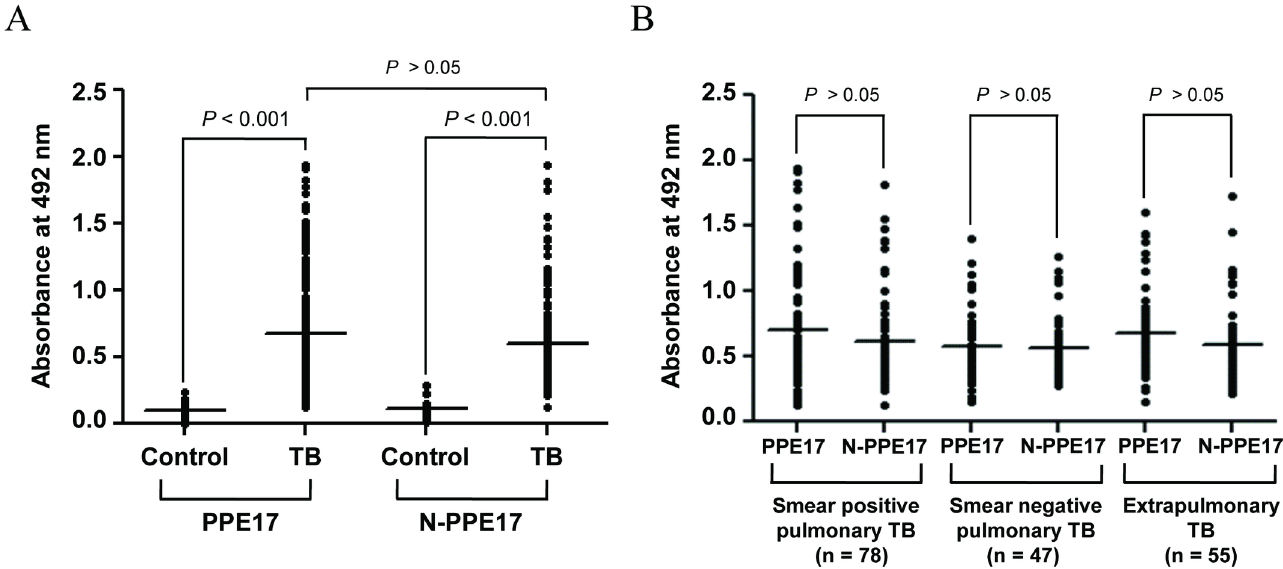
Fig 1. The full-length PPE17 protein (PPE17) as well as the N-terminal fragment of PPE17 (N-PPE17) can discriminate active TB patients (n = 180) from BCG-vaccinated healthy controls (n = 20). (A) The mean absorbance values (OD 492 ) of TB patients versus healthycontrols were comparedfor PPE17 and N-PPE17 proteinsfollowingEIA. (B) The EIA absorbance values shown in Fig 1A were re-plotted to compare the antibody levels of the smear positive pulmonaryTB (n = 78), smear negativepulmonaryTB (n = 47) and extrapulmonary TB (n = 55) patients betweenthe PPE17 and N-PPE17 proteins. Horizontalline indicatesthe mean